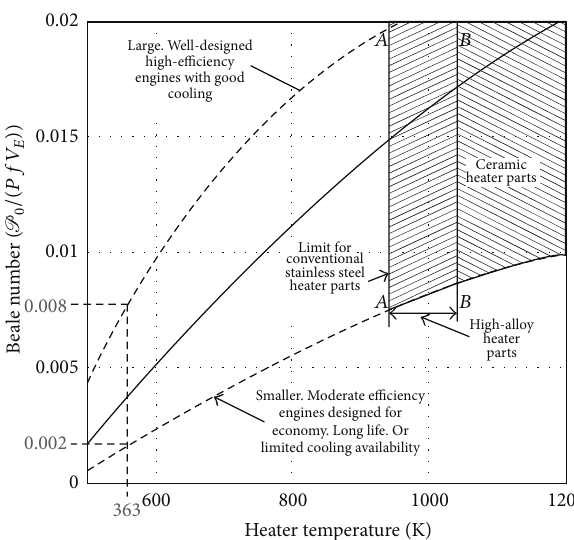
Figure 3: Graph of Beale number vs. heater temperature for a range of Stirling engines [5].